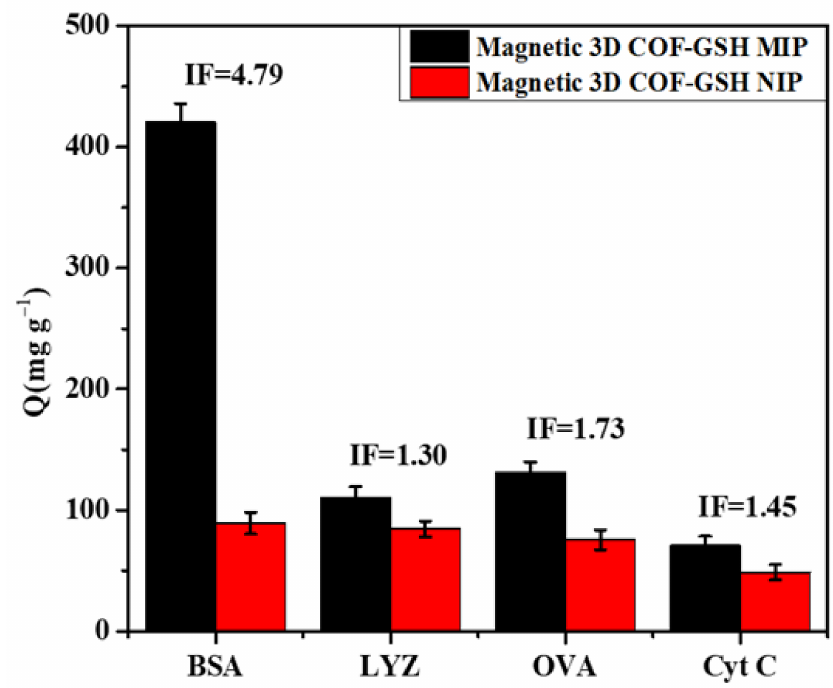
Figure 5. Rebinding selectivity of magnetic 3D COF–GSH MIPs and NIPs for different